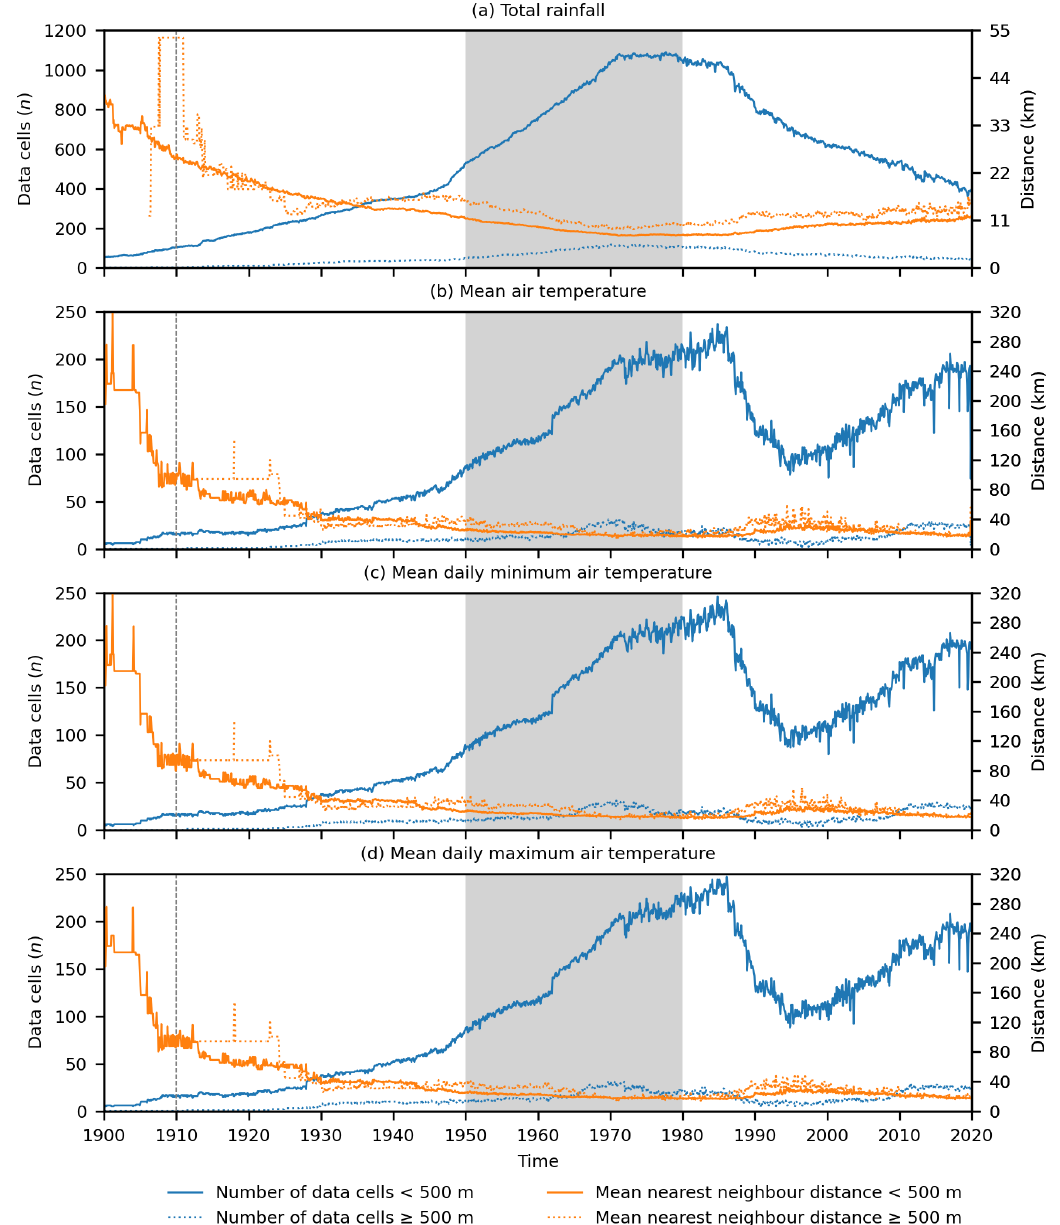
Figure 3. Monthly time series of the number of data cells (which relates closely to the number of weather stations) and the mean nearest- neighbour distance of data cells contributing to climatologically aided natural neighbour interpolation across New Zealand at < 500m ele- vation and ≥ 500m elevation for (a) total rainfall, (b) mean air temperature, (c) mean daily minimum air temperature, and (d) mean daily maximum air temperature. Missing data indicate an absence of data cells in an elevational category. The grey areas show the period (1950– 1980) over which the climatologies used to aid interpolation apply, and the dashed lines indicate the temporal limit of reliable